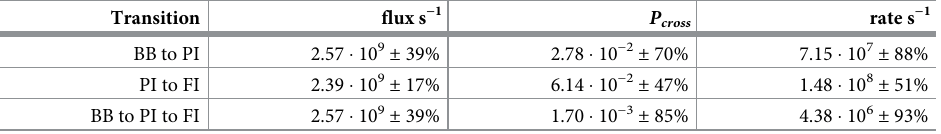
Table 1. Results from the RETIS simulations.